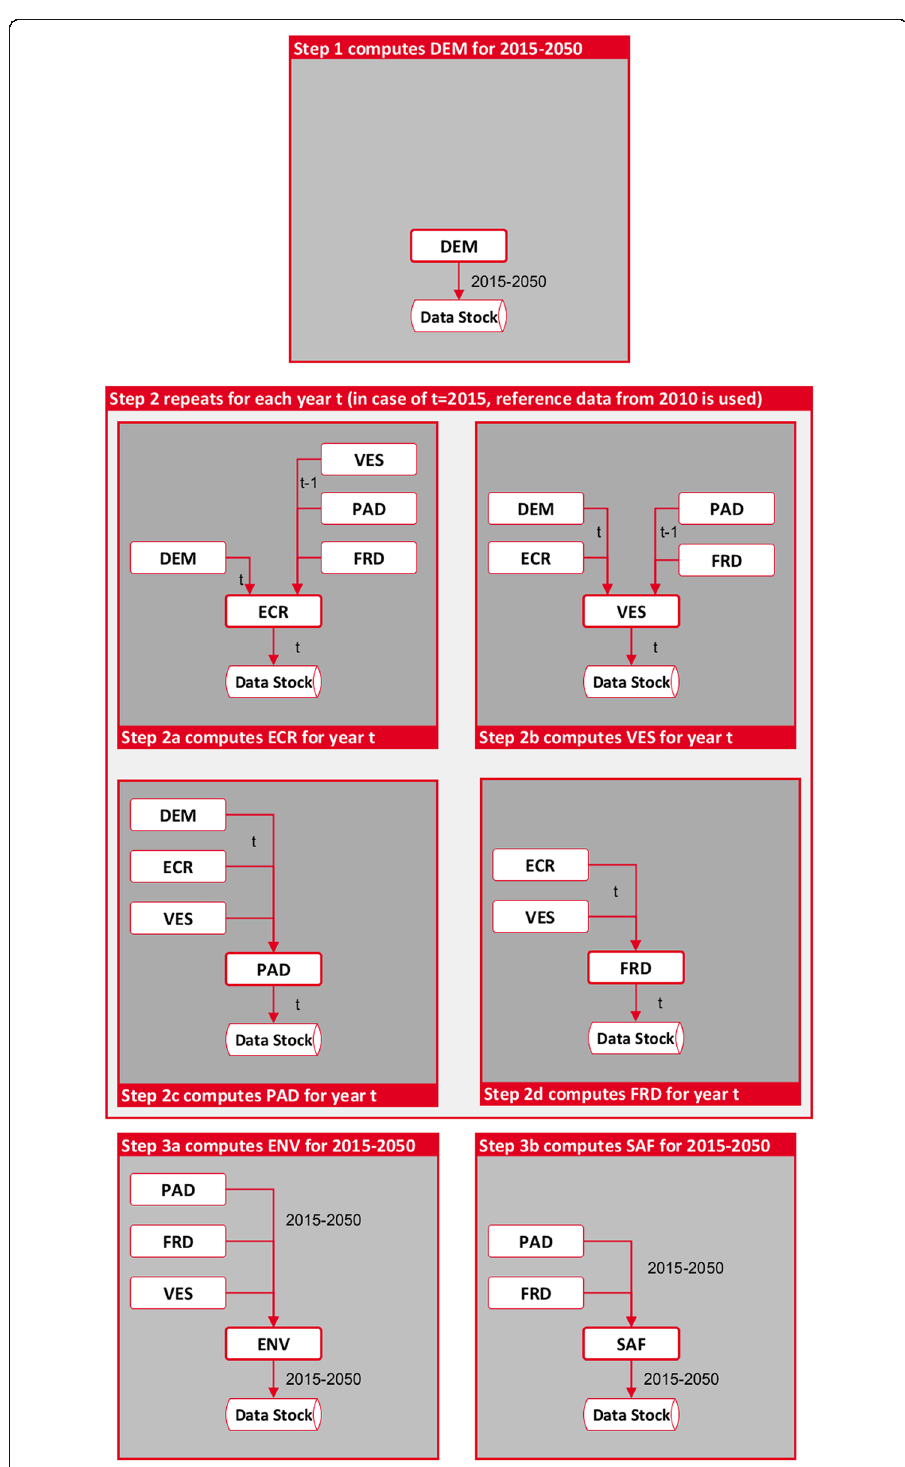
Fig. 9 Model execution